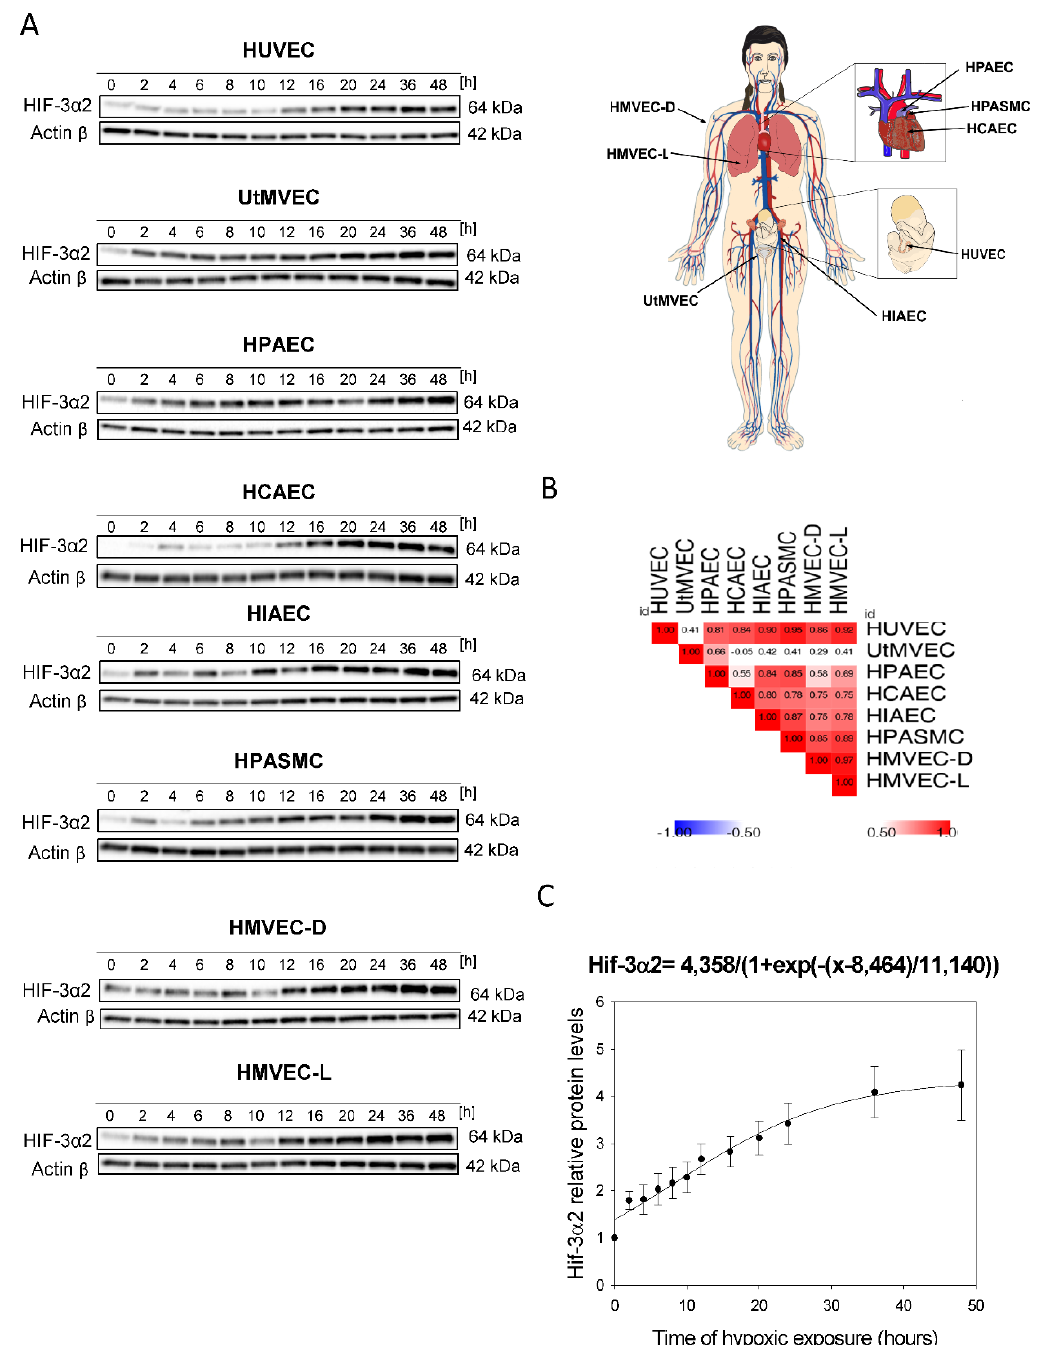
Figure 1: Prolonged hypoxia results in the accumulation of HIF-3α2 in human HUVECs and other endothelial cell types. HUVEC, UtMVEC, HPAEC, HCAEC, HIAEC, HPASMC, HMVEC-D and HMVEC-L, cells were exposed to hypoxia for the time periods specified and total RNA and protein ly- sates were collected. ( A ) The changes in HIF-3α2 protein levels were evaluated by western blot nor- malized to β-actin and total protein levels and related to the normoxic control. In all of the endothelial cell types, the HIF-3α2 isoform is expressed. The HIF-3α2 protein level analysis was performed in par- allel with HIF-1α and HIF-2α analyses that were presented in Bartoszewski et al. (2019). The raw data are presented in Supplementary data (PDF). ( B ) Spearman’s correlation of the hypoxia induced HIF- 3α2 protein levels change in different human ECs. The mathematic representation of HIF-3α2 changes in human ECs exposed to hypoxia. ( C ) The changes in HIF-3α levels (from all ECs tested) during hy- poxia time course were analyzed using the sigmoid 3-parameter function (using 200 iterations, P < 0.005). The error bars represent